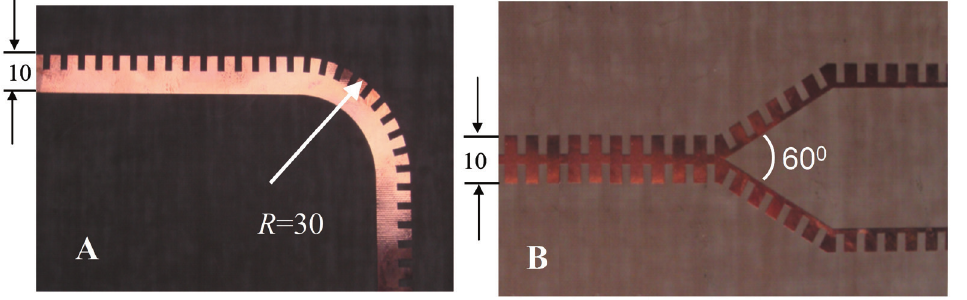
Figure 7: Photos of fabricated planar plasmonic 90 ° bend and Y-shaped beam splitter. (A) The 90 ° bend, (B) Y-shaped beam splitter. Repro- duced from [40] with permission.